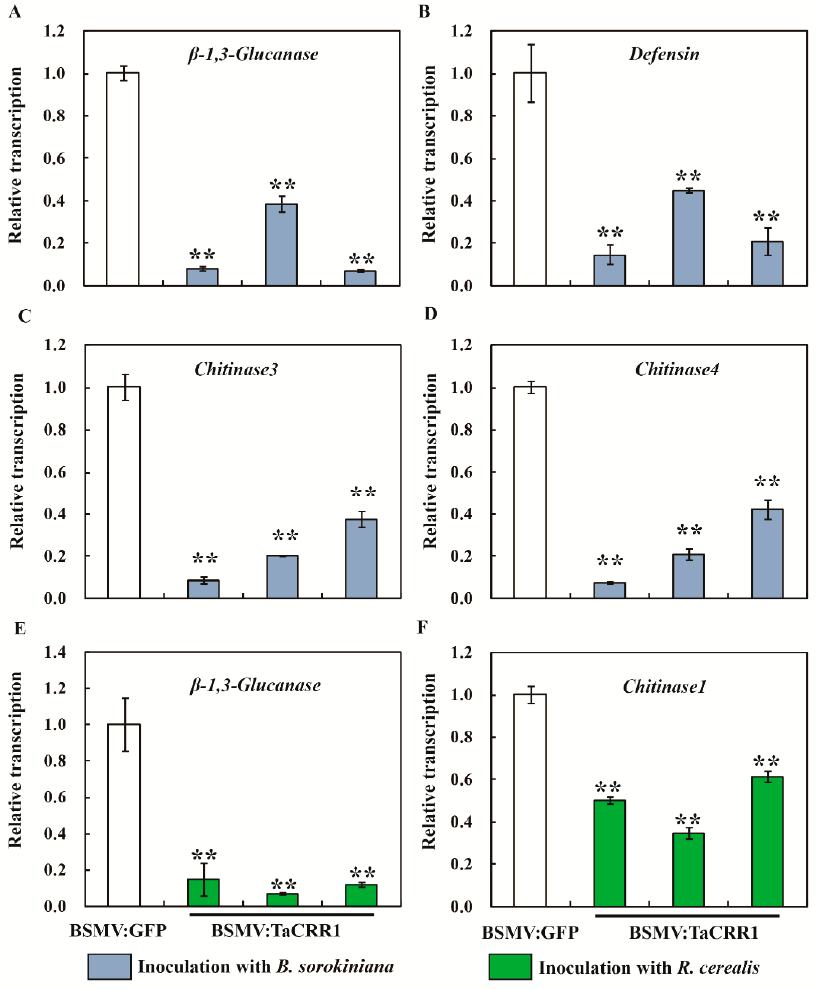
Figure 8. Transcription profiles of pathogenesis-related genes β -1,3-Glucanase , Defensin , Chitinase1 , Chitinase3, and Chitinase4 in BSMV: GFP- and BSMV: TaCRR1-infected wheat plants after infection by pathogens. Relative transcriptional abundances of the tested genes β -1,3-Glucanase ( A ), Defensin ( B ), Chitinase3 ( C ), and Chitinase4 ( D ) in BSMV: TaCRR1-infected Yangmai 6 plants were quantified relative to those in BSMV: GFP-infected control plants after B. sorokiniana inoculation for 15 days. Relative transcriptional abundances of the tested genes β -1,3-Glucanase ( E ) and Chitinase1 ( F ) in BSMV: TaCRR1-infected CI12633 plants were quantified relative to that in BSMV: GFP-infected control plants after R. cerealis inoculation for 15 days. Statistically significant di ff erences between